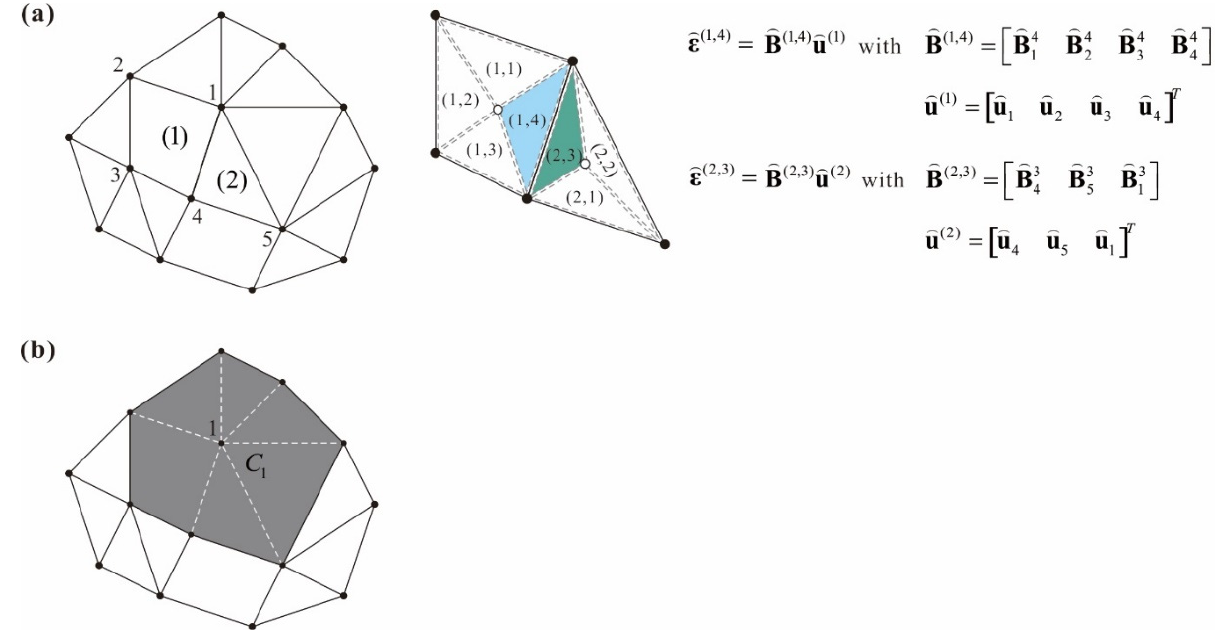
Figure 3. Description of the cover region: ( a ) Finite element mesh and linear/higher order strain part and 2, ( b ) cover region corresponding to the node 1.